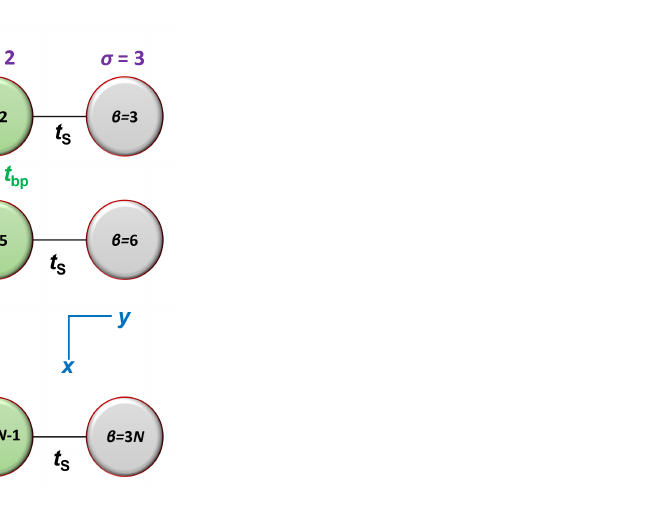
Figure 1. The FWM. σ = 1,2,3 is the strand index, ν = 1,2, . . . N is the row or monomer index, and β = 1,2, . . . ,3 N is the site index. The relation between these indices is β = 3 ( ν − 1 ) + σ . In the absence of backbone disorder, all interaction integrals t S are equal, and all deoxyribose on-site energies E S are equal as well. The x and y axes are also